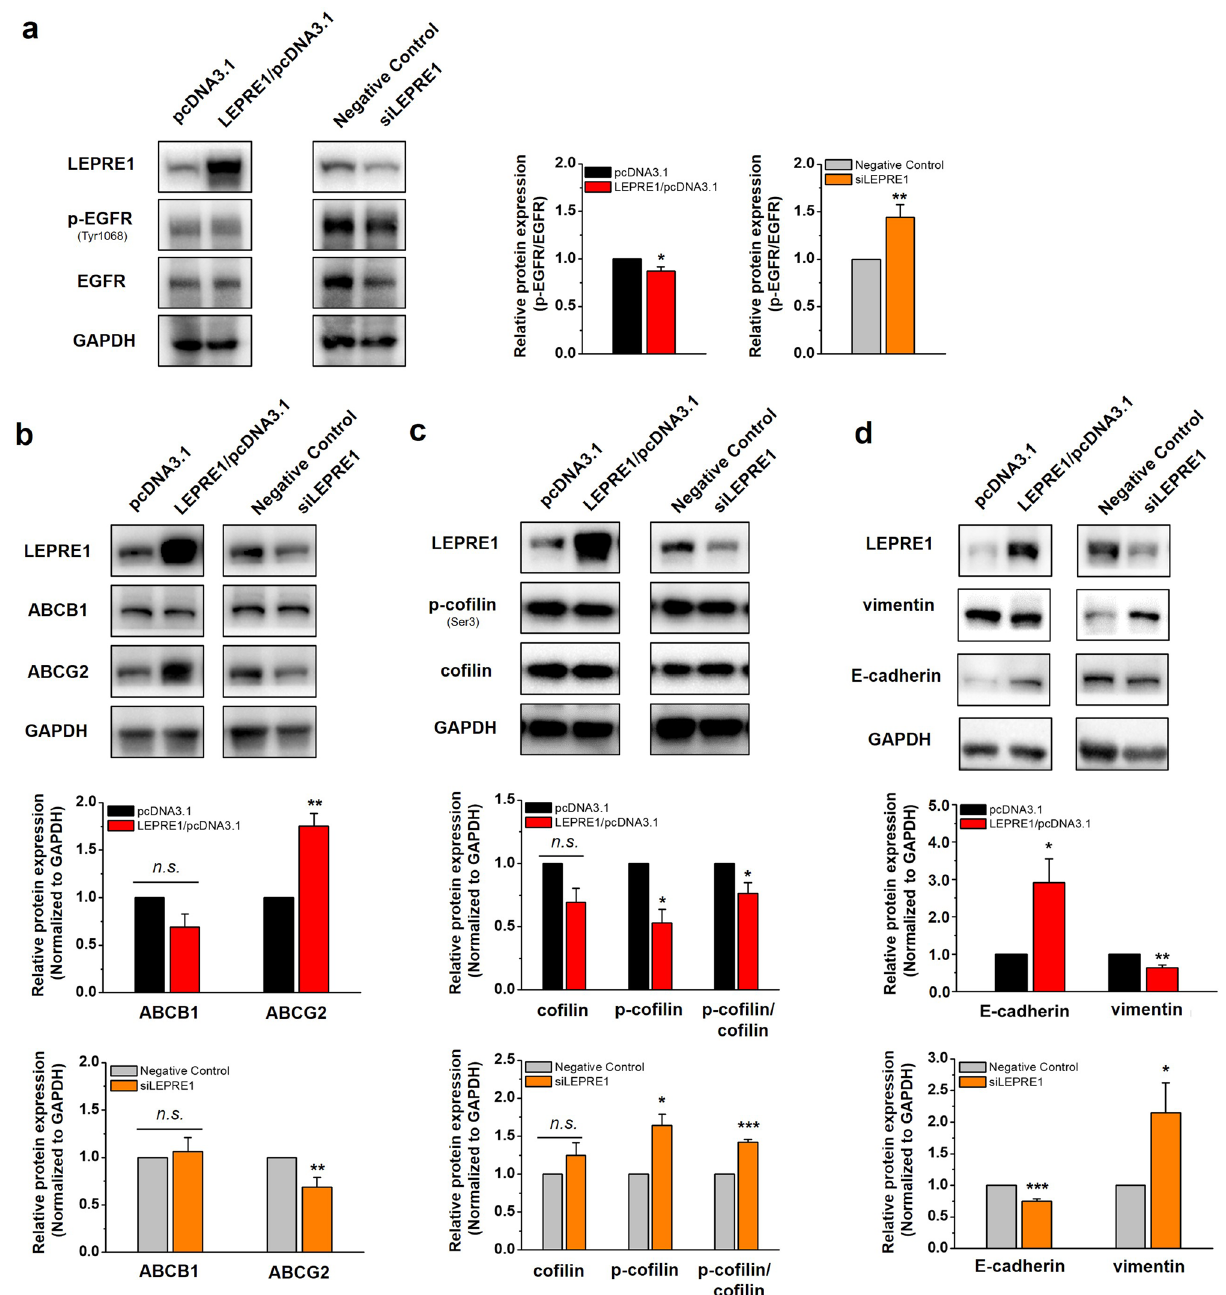
Figure 6. LEPRE1 affects the expression of EMT and MET markers in lung cancer-derived A549 cells. (a – d ) Western blot analysis of EGFR and p-EGFR ( a ), ABCB1 and ABCG2 ( b ), p-cofilin and cofilin ( c ), and vimentin and E-cadherin ( d ) in transfected A549 cells. The relative expression levels of p-EGFR/EGFR ( a ), ABCB1 and ABCG2 ( b ), p-cofilin/cofilin ( c ), and vimentin and E-cadherin (d) were normalized to GAPDH and are presented in the lower panel. GAPDH protein was used as an internal control. The data are presented as the mean ± SEM of three independent experiments. n.s. not significant; * p < 0.05; ** p < 0.01; *** p < 0.001. All western blots are pre-cut. Membranes were often stripped and reprobed for multiple